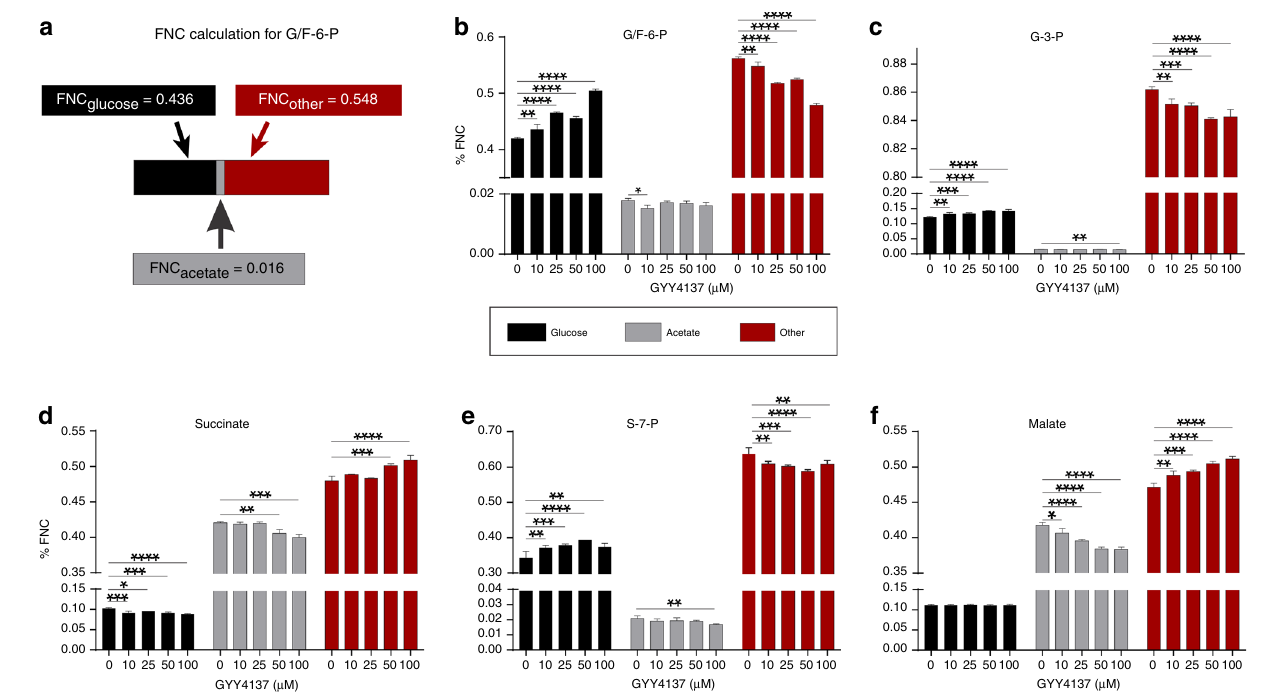
Fig. 3 Fractional nutrient contribution (FNC) of glucose and acetate exposed to GYY4137. a FNC was calculated according to a previous study 33 ; see also Materials and Methods. b , c Glycolysis is stimulated by sul fi de as is evident by an increased FNC glucose of G/F6P that corresponds with increased GYY4137 concentration, whereas the FNC acetate and FNC other decreases. The FNC glucose of G-3-P ( c ) and S-7-P ( e ) increases with higher concentrations of GYY4137. d , f The utilization of glucose is skewed towards cell wall synthesis and the PPP leading to a decrease in FNC glucose and FNC acetate of succinate and malate as GYY4137 concentration increases, as well as a corresponding increase in FNC other of these two metabolites. Data are representative of two independent experiments ( n = 5) and are shown as mean ± SD. Data were analyzed using one-way ANOVA with Sidak ’ s multiple comparisons test. All P values are relative to untreated controls (0 µ M GYY4137) for individual metabolites. * P < 0.05, ** P < 0.01, *** P < 0.001, and **** P < 0.0001. Source data are provided as a Source Data fi